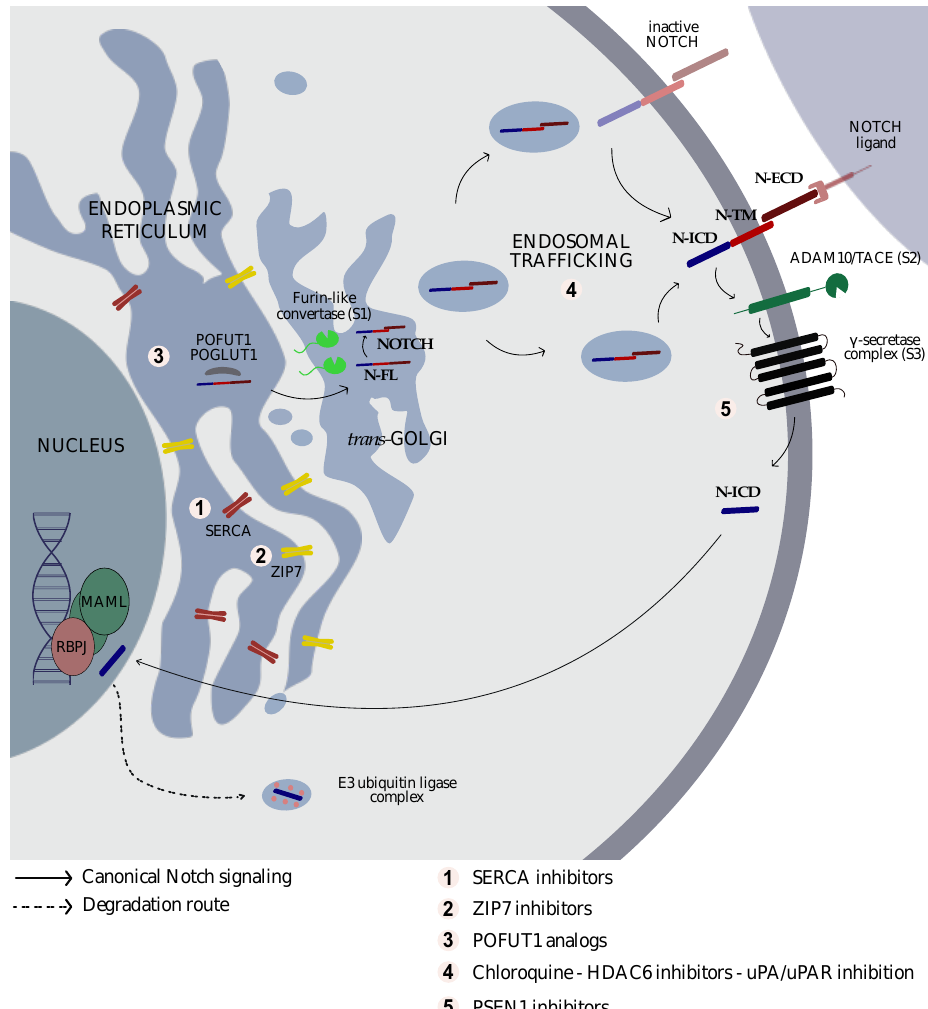
Figure 1. Schematic representation of Notch signaling and proteolytic processing. NOTCH receptors are cell surface receptor proteins. Interaction with mutual ligands activates two consecutive proteolytic cleavages at the extracellular site, one by a metalloprotease (ADAM10 / TACE) (S2), followed by another by a γ -secretase (S3), resulting in the release of N-ICD. N-ICD is translocated into the nucleus where it interacts with a transcription-activating complex. In the presence of NOTCH1 mutations, N-ICD is constitutively active, independent of ligand binding. The figure shows an overview of Notch tra ffi cking routes and the corresponding targets for therapeutic intervention. N-FL: NOTCH full length; N-TM: NOTCH transmembrane; N-ICD: NOTCH intracellular